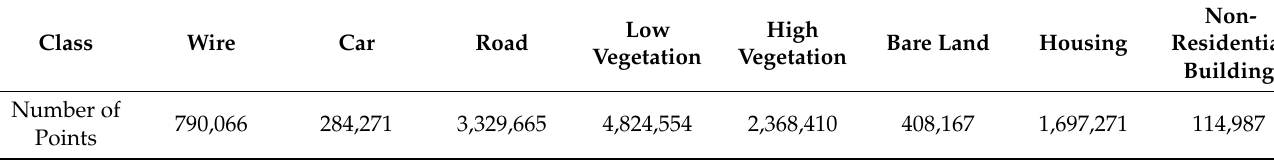
Table 1. Reference points for the eight